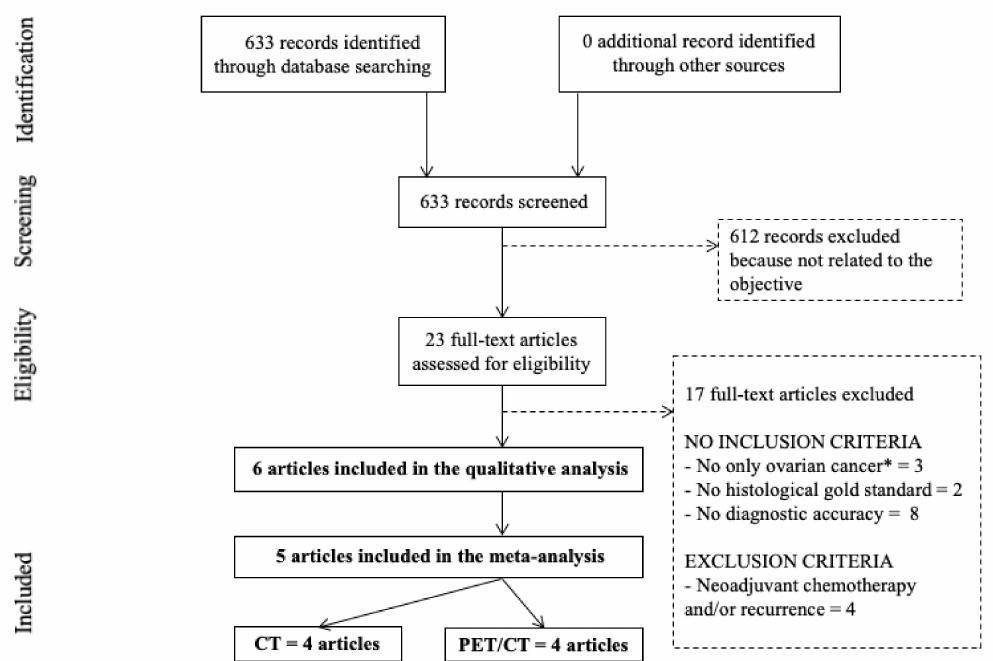
Figure 1. PRISMA flow chart. * borderline ovarian tumors, benign ovarian tumors, other primary cancers. CT: computed tomography; PET/CT: positron emission tomography/computed